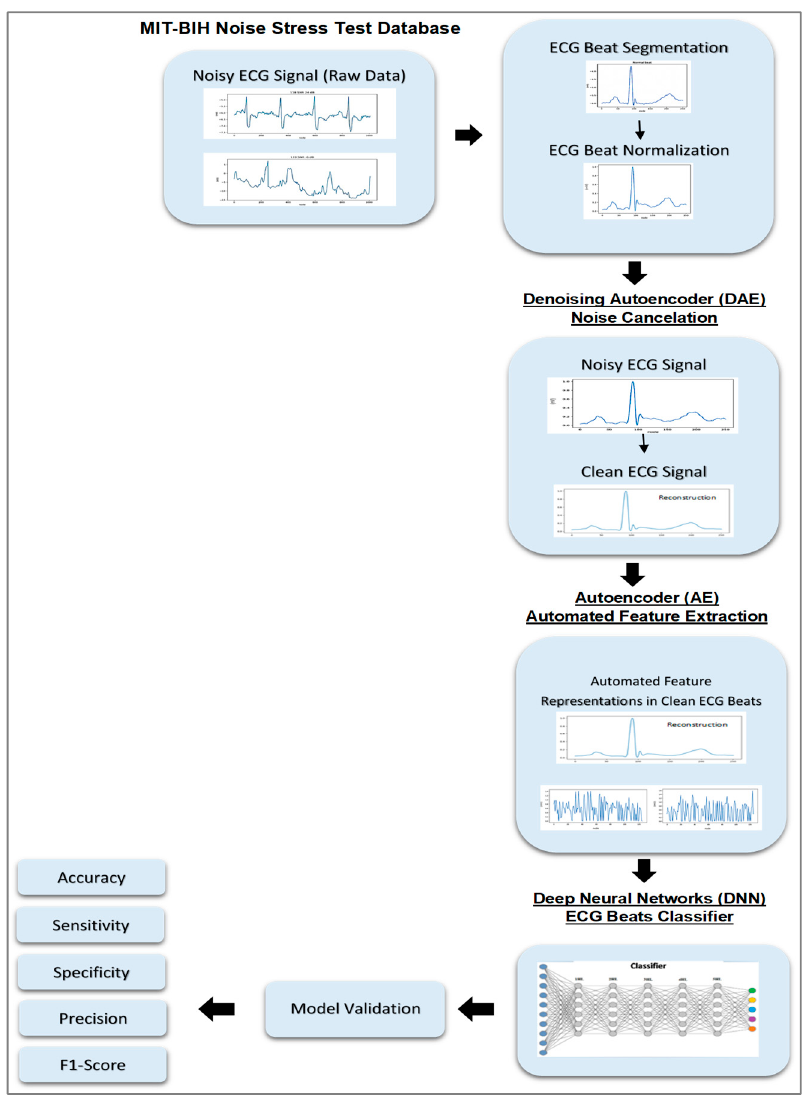
Figure 1. The proposed deep learning (DL) structures.